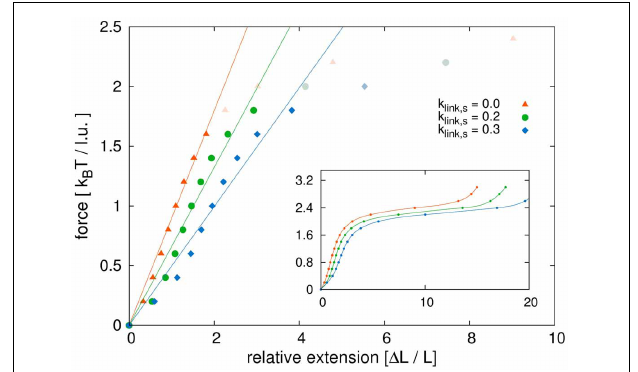
FIGURE 9 | Initial region of stress-strain curve. Shown is a close-up view of the linear region of the stress-strain curves. We compare model sister chromatids with different link concentrations. We fitted the initial parts of the curves before the plateau area with linear functions. The dark points are those used for the fits, while the points in light color belong to the force extension curves but were not considered for the linear fits. The results show that non-tethered model chromatids have the highest Young‘s modulus and the modulus decreases with increasing link concentrations. The values for the Young’s modulus are: Y 1 = 0 . 90 k B T / l . u . for k link , s = 0 . 0,